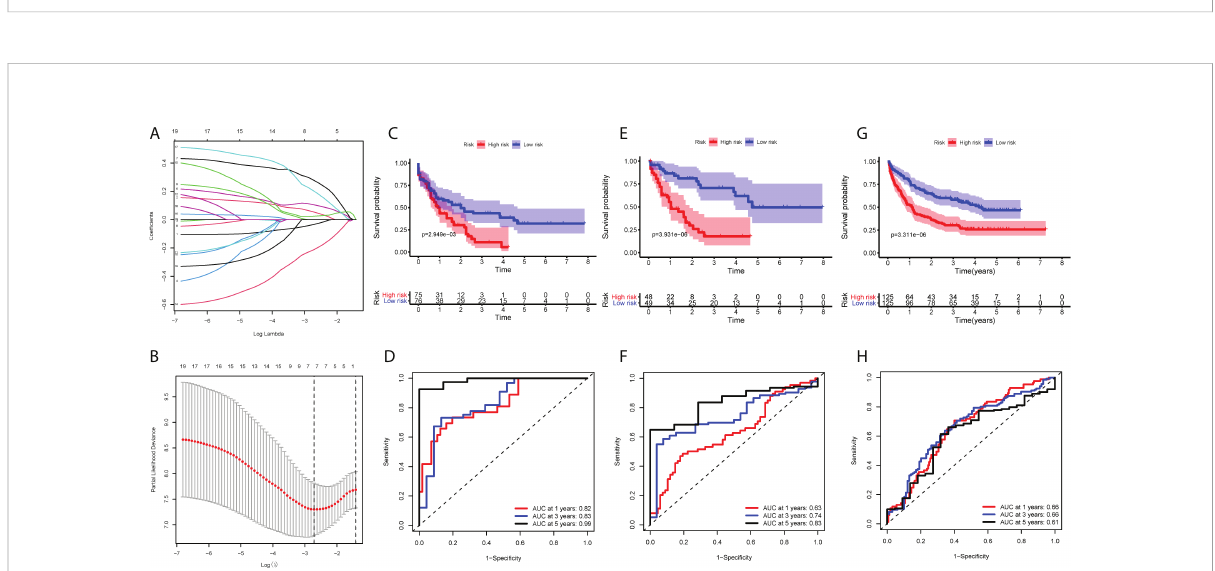
FIGURE 5 Construction of the COX regression model. (A) LASSO coef fi cient pro fi les of 19 candidate SIGs. (B) Tuning parameter ( l ) selection cross ‐ validation error curve. The vertical lines were drawn at the optimal values determined by the minimum criteria and the 1 ‐ SE criteria. (C, E, G) OS in patients with high vs. low risk scores depicted by Kaplan-Meier plots in the TCGA-AML-97, TCGA-AML-151 and GSE106291 cohorts. (D, F, H) ROC curves depicting the accuracy of the Cox regression model in identifying AML subtypes with poor prognosis in the TCGA-AML-97, TCGA- AML-151 and GSE106291